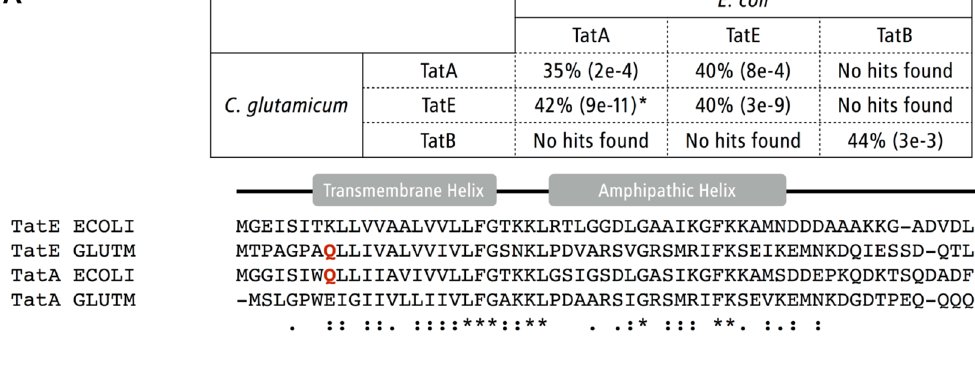
cross-linking sites on transmembrane helix 5 of TatC 14,15,43 . In vesicles containing TatC 205B pa together with TatEB instead of TatAB, the UV-dependent cross-links were weaker owing to a lower TatC content of those vesicles ( α TatC, compare lanes 2 and 4). As expected, the TatA adduct (red square) was no longer visible. Instead a new ~30 kDa cross-link of TatC 205B pa to TatE appeared (orange square in α TatC, α TatE, lane 4), indicating that TatE, exactly as TatB and TatA, contacts TatC via its fifth transmembrane helix. Previously it was found that Bpa when incorporated into TatE at position 9 of its transmembrane helix cross-links to TatC 28 . It is therefore reasonable to assume that the contact of TatE with residue 205 in helix five of TatC reflects the alignment of both transmem- brane helices as demonstrated before for TatB and TatA 5,24,42 . However, as discussed above the oppositely charged transmembrane helices of TatE and TatB are not likely to occupy exactly the same binding sites on TatC. Interestingly, the DCCD-mediated contact between TatB and TatE (Fig. 6A, lane 4, orange triangle), was almost gone in the presence of TatA (lane 6). Instead membrane vesicles containing all four Tat components gave rise to new adducts that by size and immuno-reactivity represent TatE-TatA oligomers (orange dots, compare lanes 4 and 6, 10 and 12). If this reflects a true exchange of TatB for TatA as the binding partner of TatE following the recruitment of TatA to the substrate-bound TatBC receptor complex, is speculative at this point of time. The DCCD-mediated cross-links that we obtained between TatE and TatA, however, suggest that TatE could fulfil a role in the recruitment of TatA to the TatBC receptor complex through hetero-oligomerization with TatA. Because in vivo , TatE is present only in sub-stoichiometric amounts compared with TatA 20 , TatE could conceiva- bly function as a nucleation point for a TatBC-dependent oligomerization event of TatA. In conclusion, our results suggest that TatE paralogs have overlapping functions between TatA and TatB. Similar to TatB, TatE is involved in substrate binding yet possibly at a later step. Although it docks at transmem- brane helix five of TatC much like TatA and TatB do, the individual interacting epitopes of TatC are likely to vary. We propose that TatE could play a role in the oligomerization of TatA.